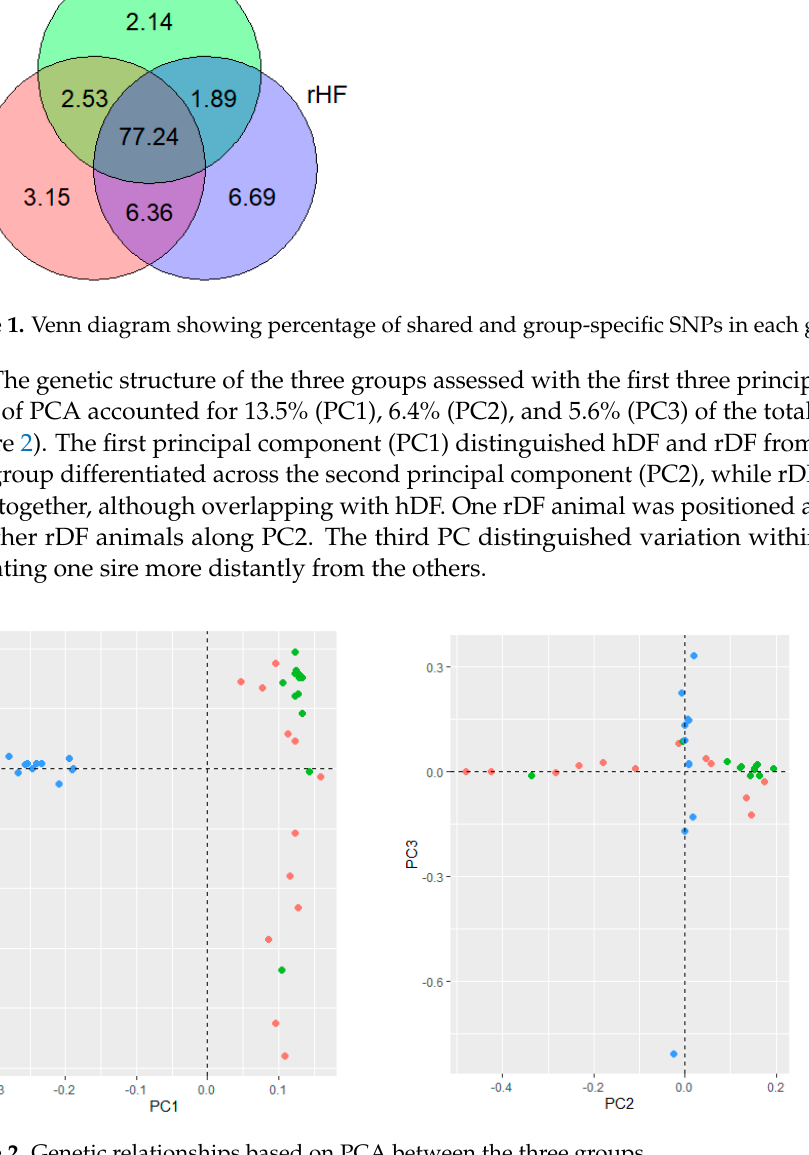
Figure 2. Genetic relationships based on PCA between the three groups.